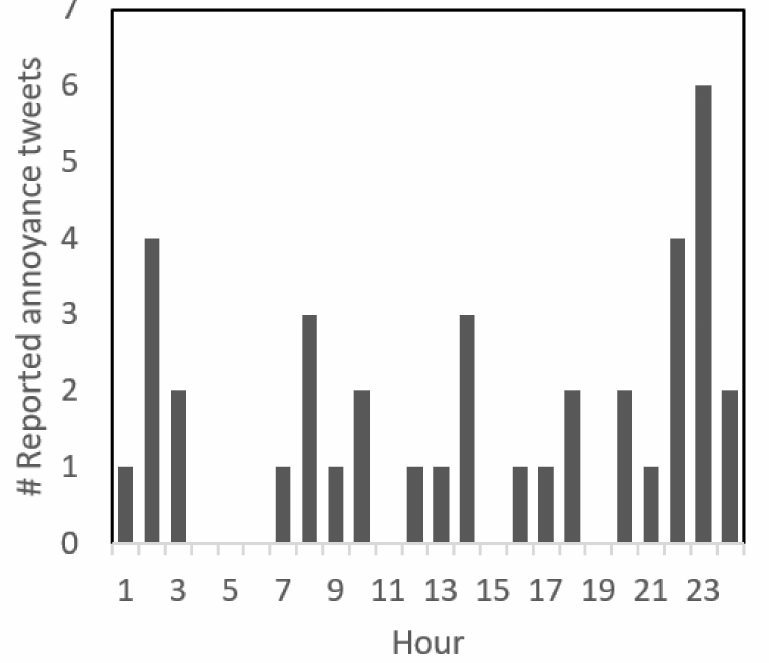
Figure 1. Frequency and time at which tweets were reported. Representing hourly intervals, the x -axis represents the 24 h period, i.e., midnight-to-midnight.